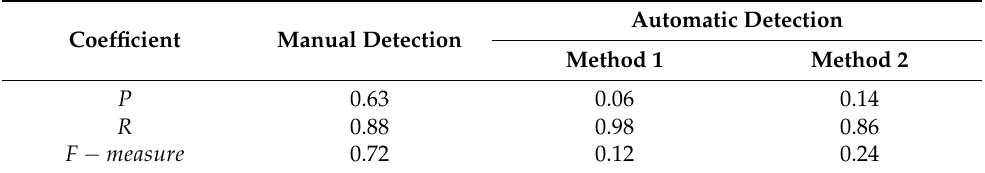
Table 8. Average values of the obtained parameters P , R and F − measure . Coefficient